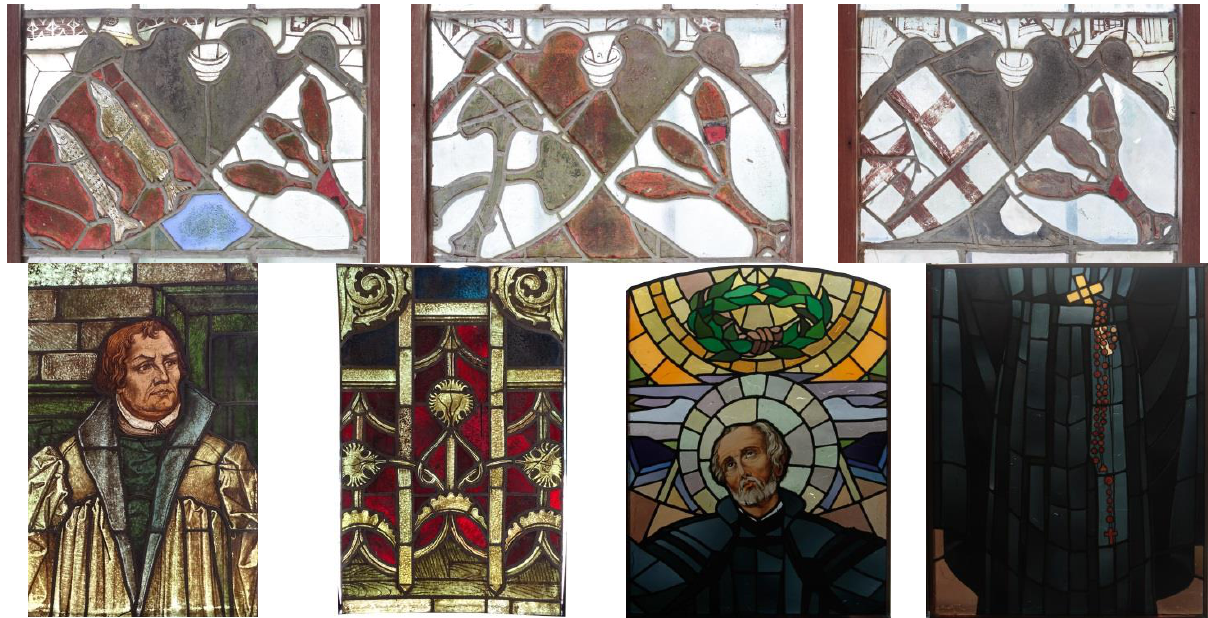
Figure 1. Overview of the Polish stained glass windows. In the upper line from left to right: Koszewko nII , nIII , sIII . In the bottom line from left to right: Legnica nx3b , nx4b and Oswiecim 3b and 2b. (Oleszczuk